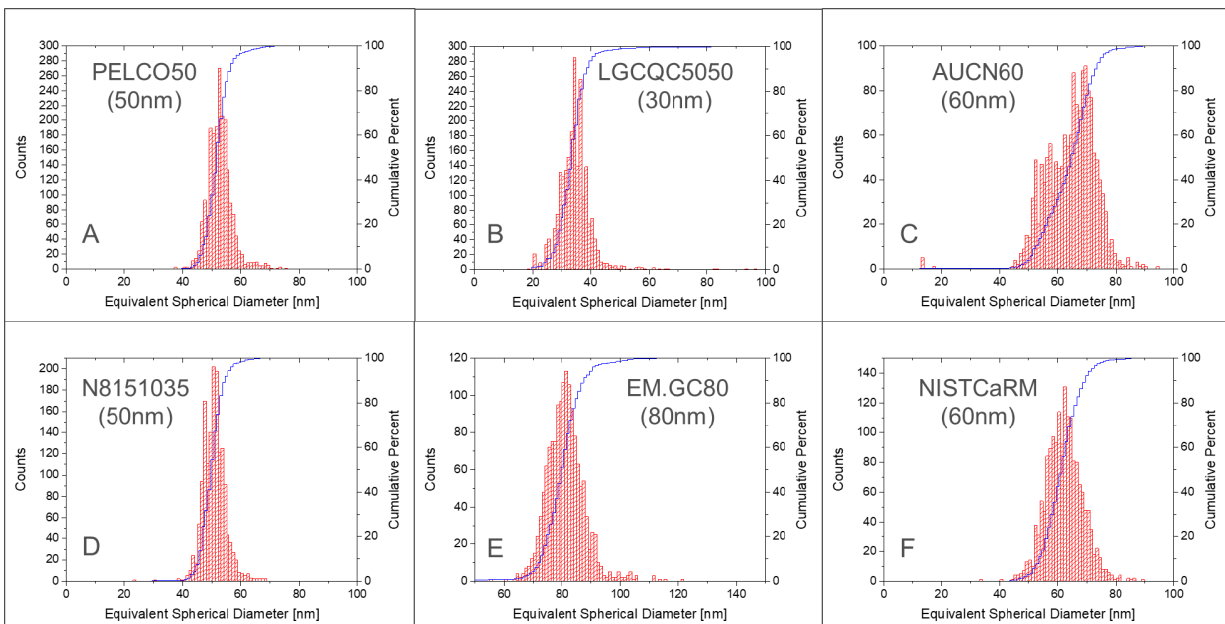
Figure 1. Number-weighted size distribution of gold particles in test samples ( A-F ) determined with spICP-MS. Histograms of absolute frequency (counts) and cumulative functions. Bin size: 1 nm.